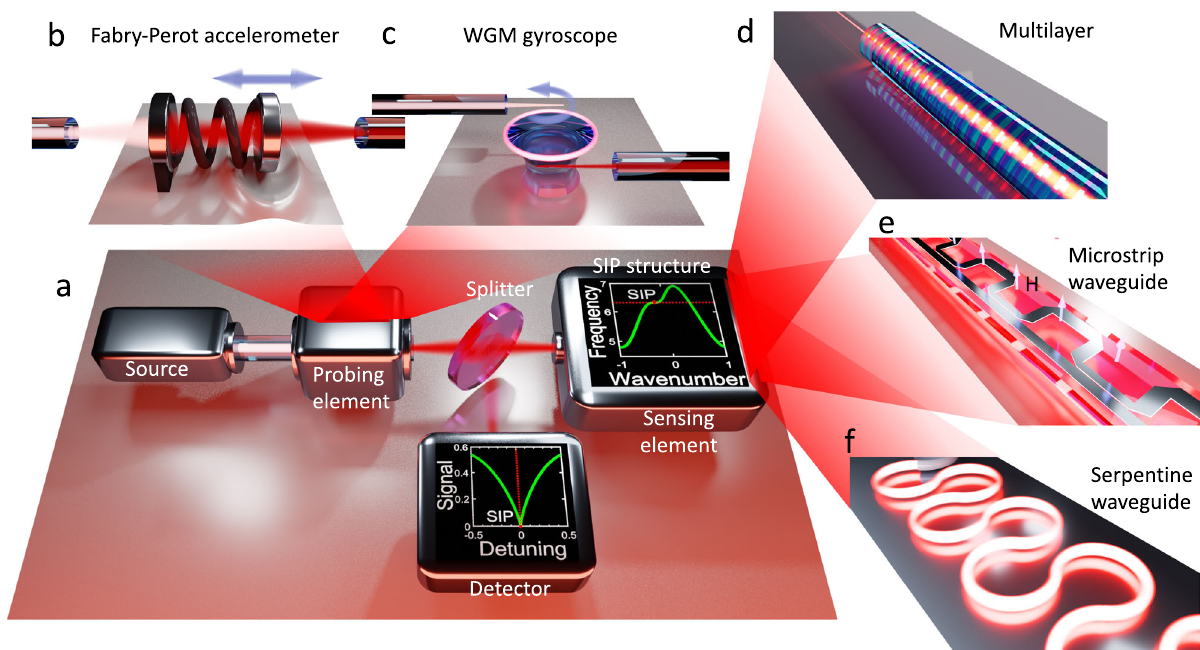
Fig. 1 Implementation of an SIP-based sensing protocol. a The schematic illustration of the sensing platform. The protocol involves a source which emits a broadband signal to the sensing platform which acts as a high-Q frequency selective fi lter, with frequency that depends on the applied perturbation. b An optomechanical Fabry – Perot cavity whose one wall is acting as a test-mass. c A whispering-gallery-mode resonator whose resonant frequency is changed due to the Sagnac effect. Different platforms supporting a stationary in fl ection point (SIP) singularity: d a multilayer structure 25,26,32 , e a coupled microstrip-waveguide 27 – 29,35 , where H indicates an external magnetic fi eld strength, or f a serpentine waveguide 36 and to the evanescent Bloch modes with I m k ð Þ > 0 ( I m k ð Þ < 0) as forward (backward) waves.